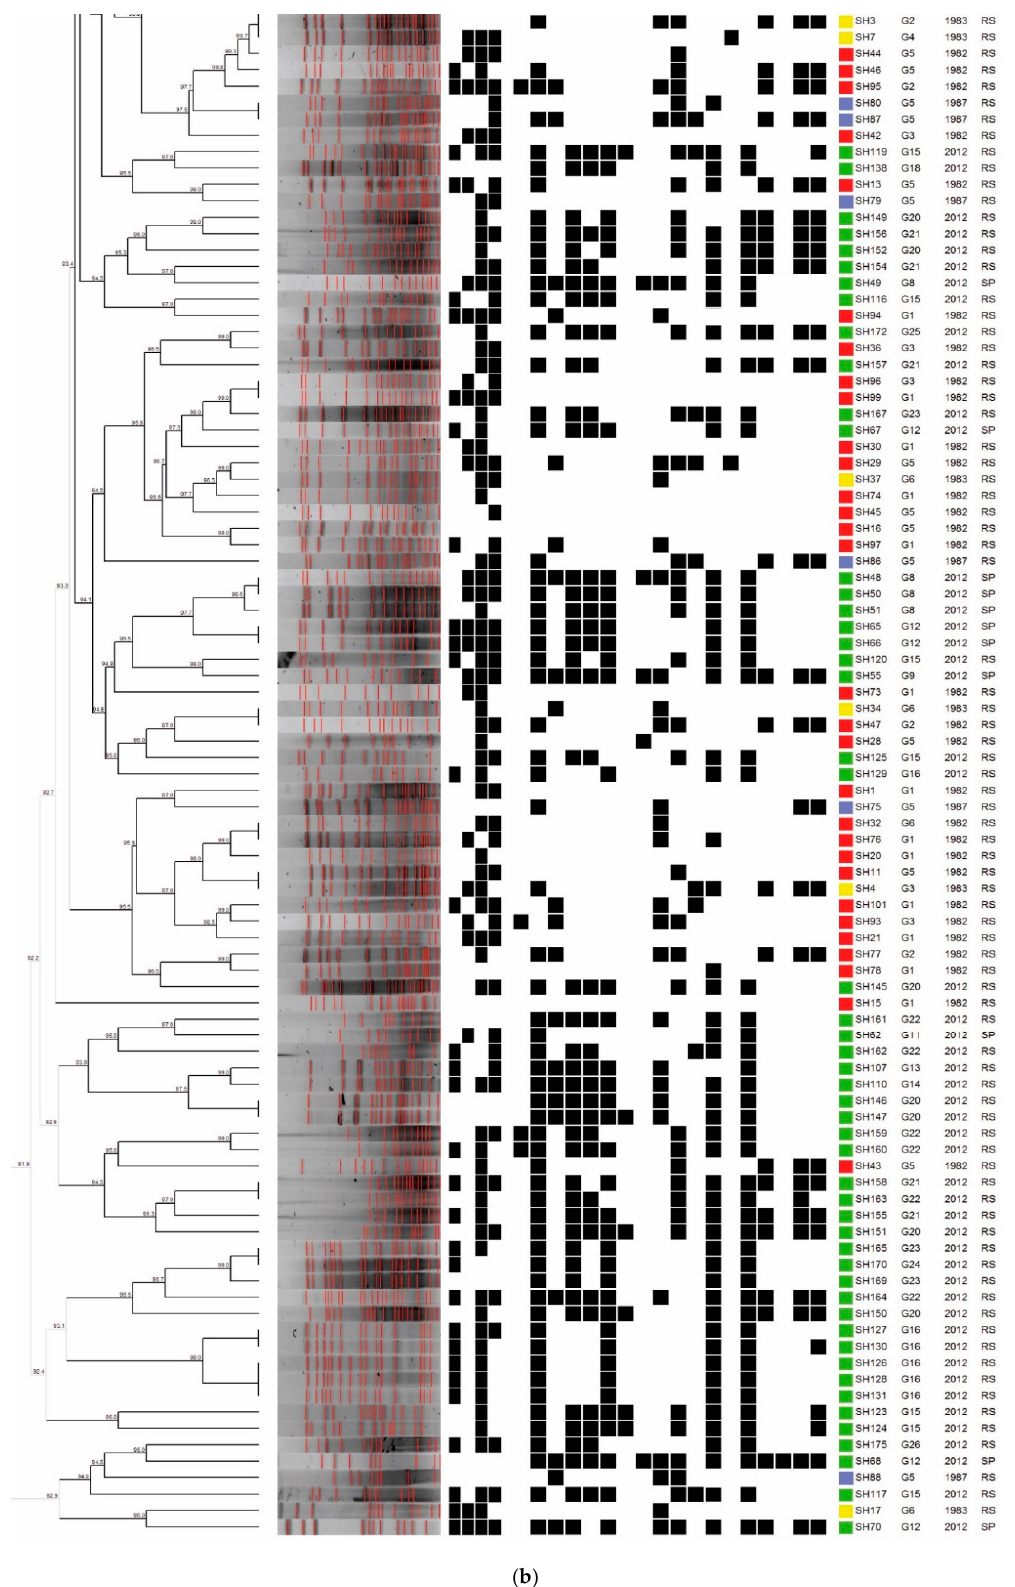
Figure 1. ( a ) Dendrogram showing the relationship among the S. hyicus pulsotypes, resistance profiles, and detection of toxin genes (Part I). ( b ) Dendrogram showing the relationship among the S. hyicus pulsotypes, resistance profiles, and detection of toxin genes (Part